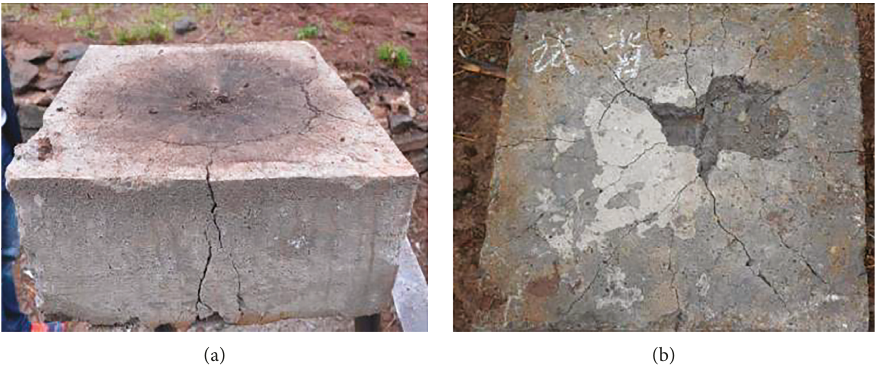
Figure 13: Damage phenomena from Test